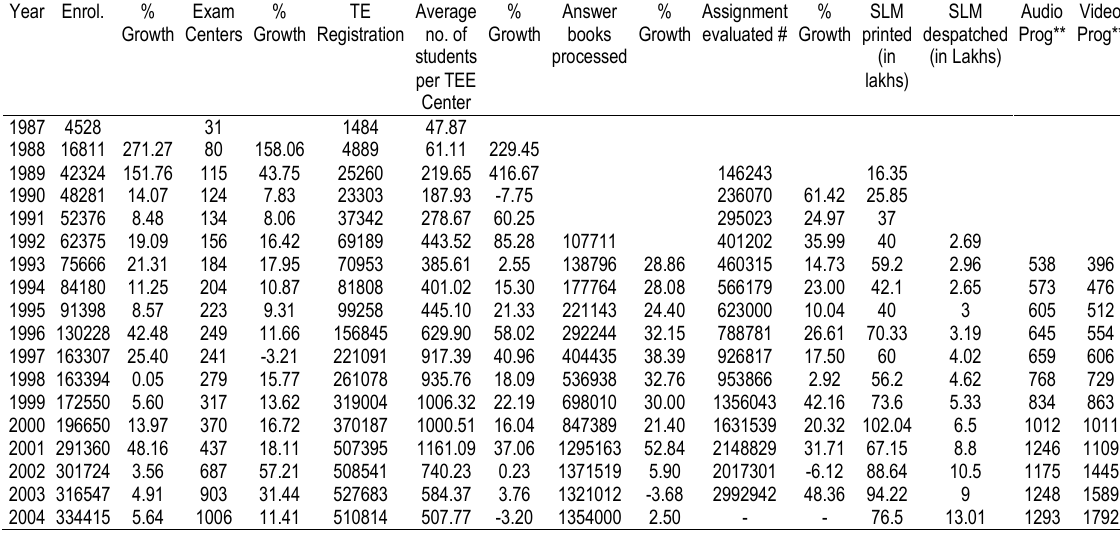
Table 3. Growth of Student Enrollment and Support Services in IGNOU Year